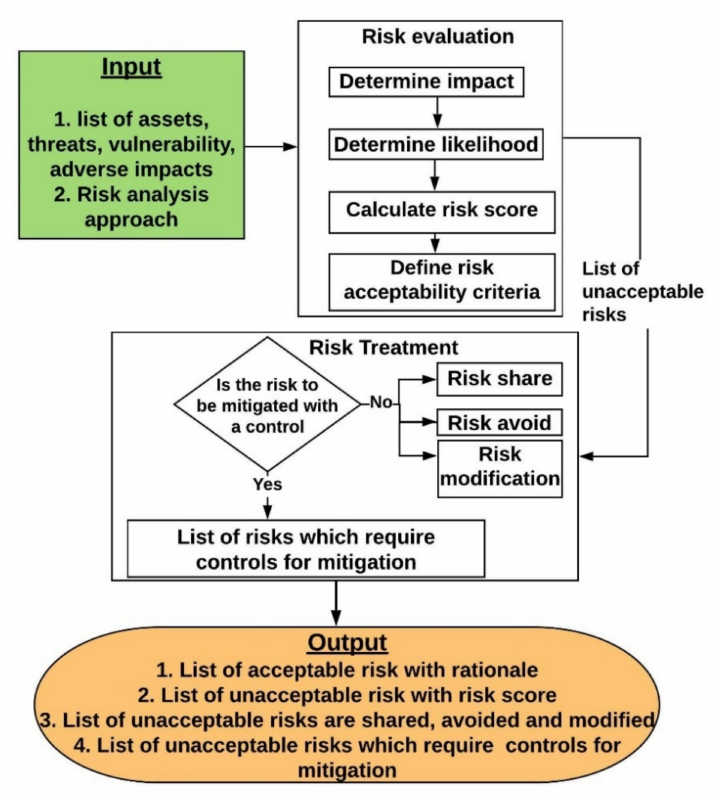
Figure 8. Steps to conduct risk evaluation and risk